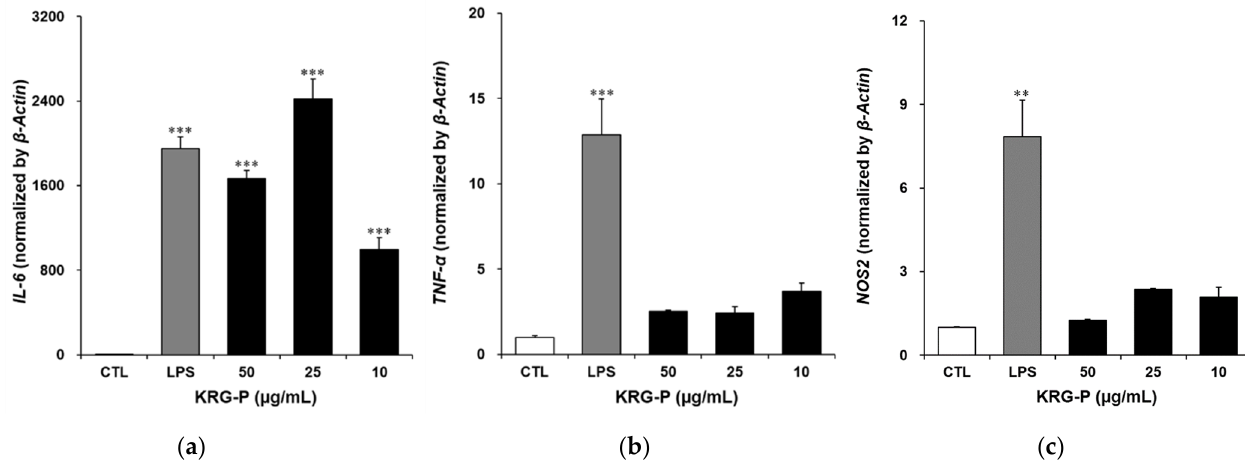
Figure 4. Effect of KRG-P of mRNA expression of IL-6 ( a ), TNF- α ( b ) and NOS2 ( c ) in RAW264.7 macrophage cells using quantitative real-time PCR. RAW264.7 cells (3.0 × 10 6 cells/well) were treated with KRG-P using a series of concentrations (10~50 µg/mL) or with LPS (500 ng/mL) in 6-well flat-bottom plates for 6 h. CTL; control, LPS; lipopolysaccharide. Data are presented as the means ± SD of three independent experiments. ** p < 0.01 or *** p < 0.001 vs. the control group.